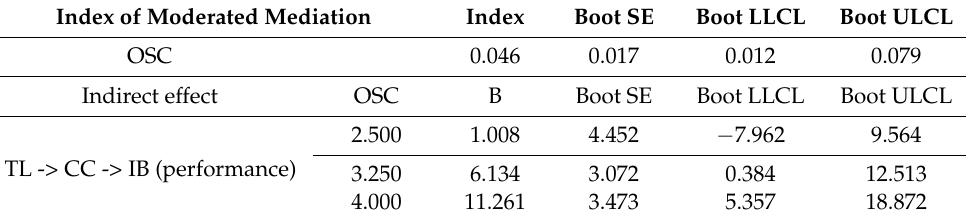
Table 8. Summary of moderated mediation effects for innovative behavior (performance).